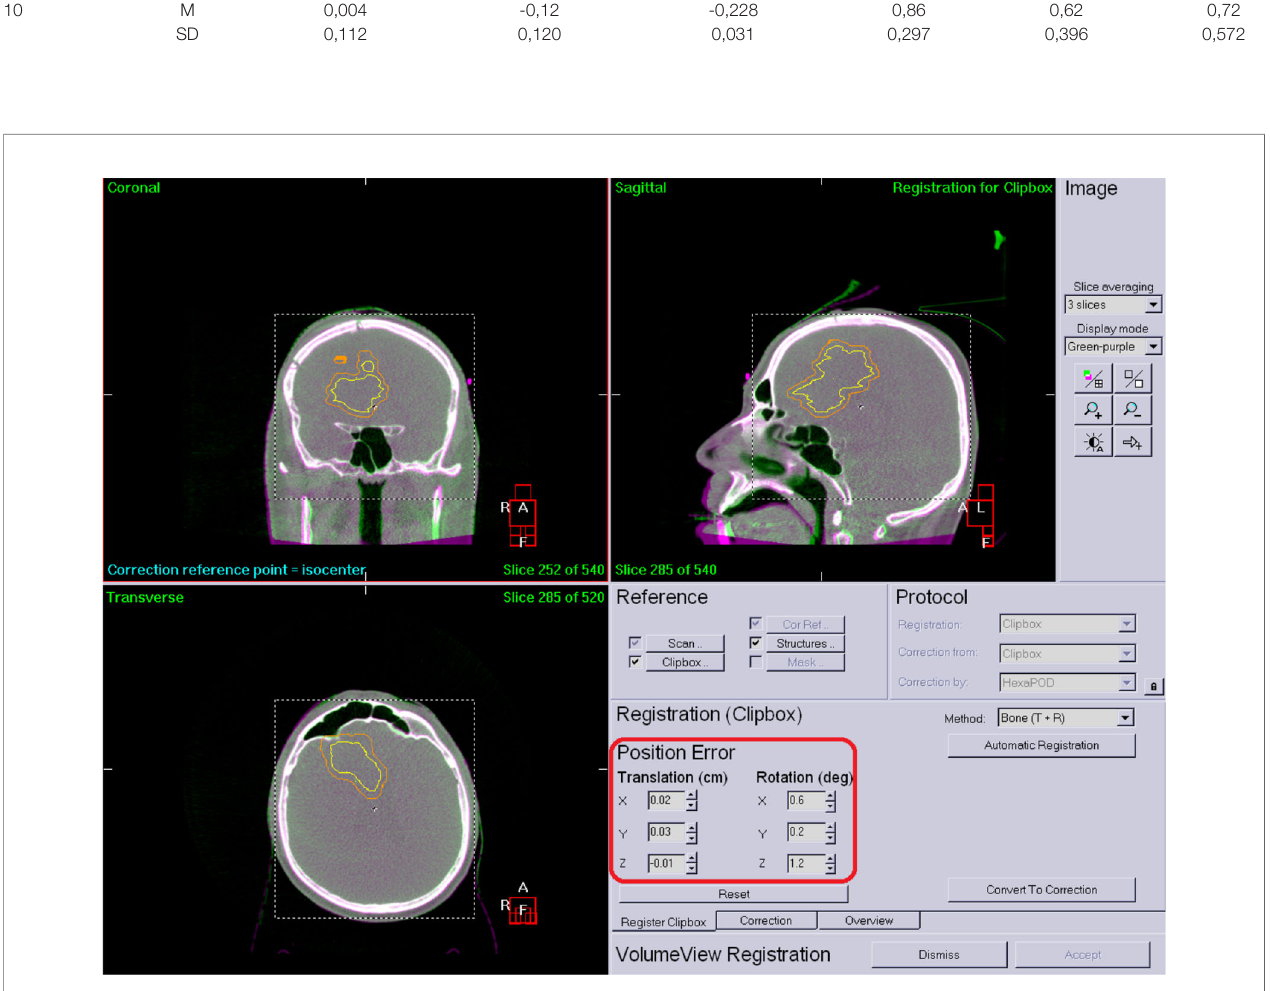
FIGURE 5 | Post-treatment HR